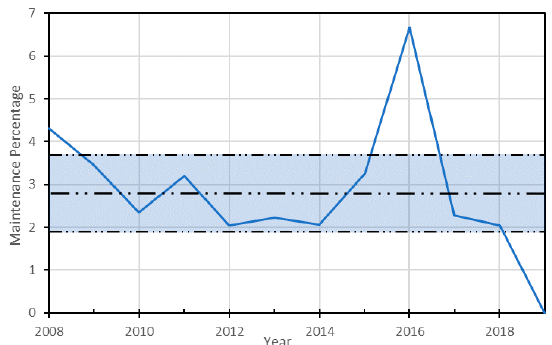
Figure 13. Percentage of all accidents in the ICAO official accident data set that have been identified with a maintenance contribution, 2008 to 2019. The shaded band illustrates the confidence interval of the average, (2.8 ± 0.9%).